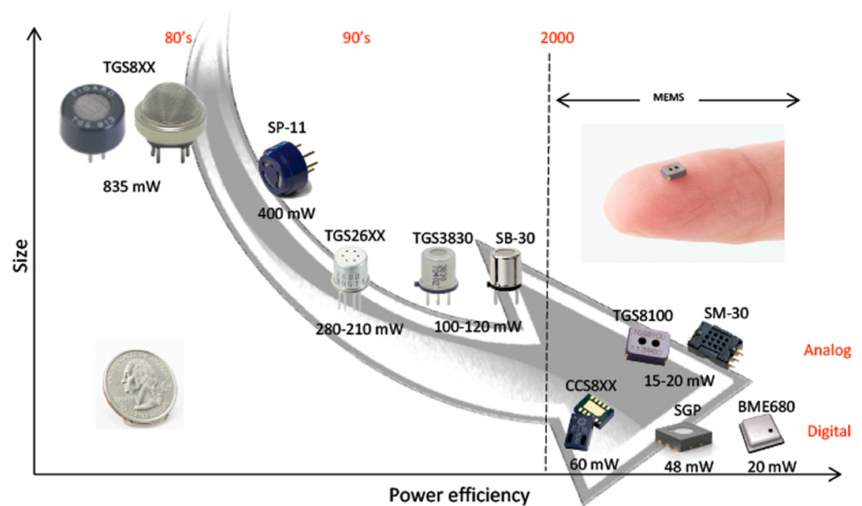
Figure 1. Reduction in the power consumption of MOX gas sensors in the last decades